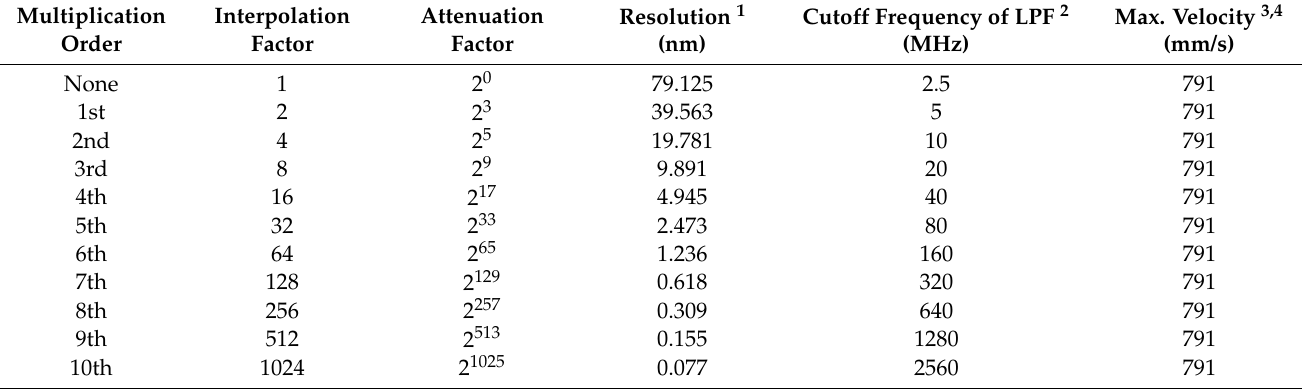
Table 2. Relationship between the multiplication order, interpolation factor, and the resolution.